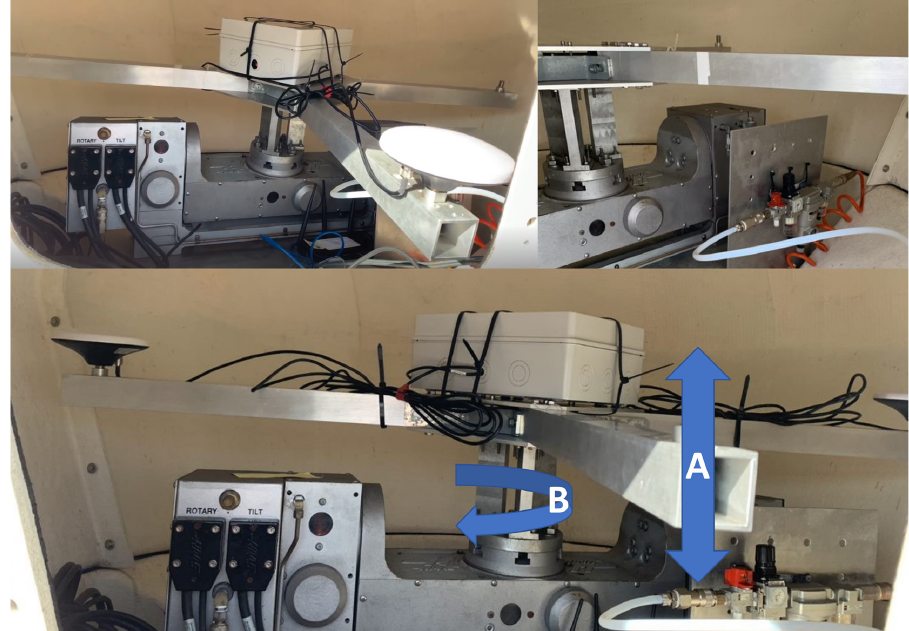
Figure 6. Motion simulator. Vertical (A) and horizontal (B) axis. To validate the smart sensor performance in this scenario, three different movements were created: rotation around (1) A axis, (2) B axis, and (3) around the A and B axes sim- ultaneously. In the rotary table, a cross brace was placed where the antenna was situated. Due to the small space inside the radome, the movement in the A-axis was limited between 0 and 14° and repetitive movements between 0 and 180° were programmed in the B-axis, as detailed in Figure 7. The black point represents the antenna at the start and changes color to white when the rotary table starts moving (the antenna changes its posi- tion). Finally, the last test was carried out mixing both movements to simulate the plat- form motion. All these tests were performed in slow motion, changing 1° every second.